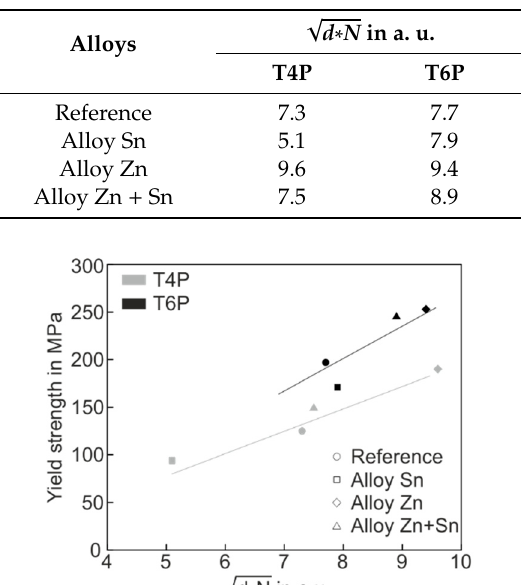
Table 6 . Hardening variables √𝑑 ∗ 𝑁 of the Mg–Si co-clusters in T4P and T6P condition (data in arbitrary units (a.u.)).